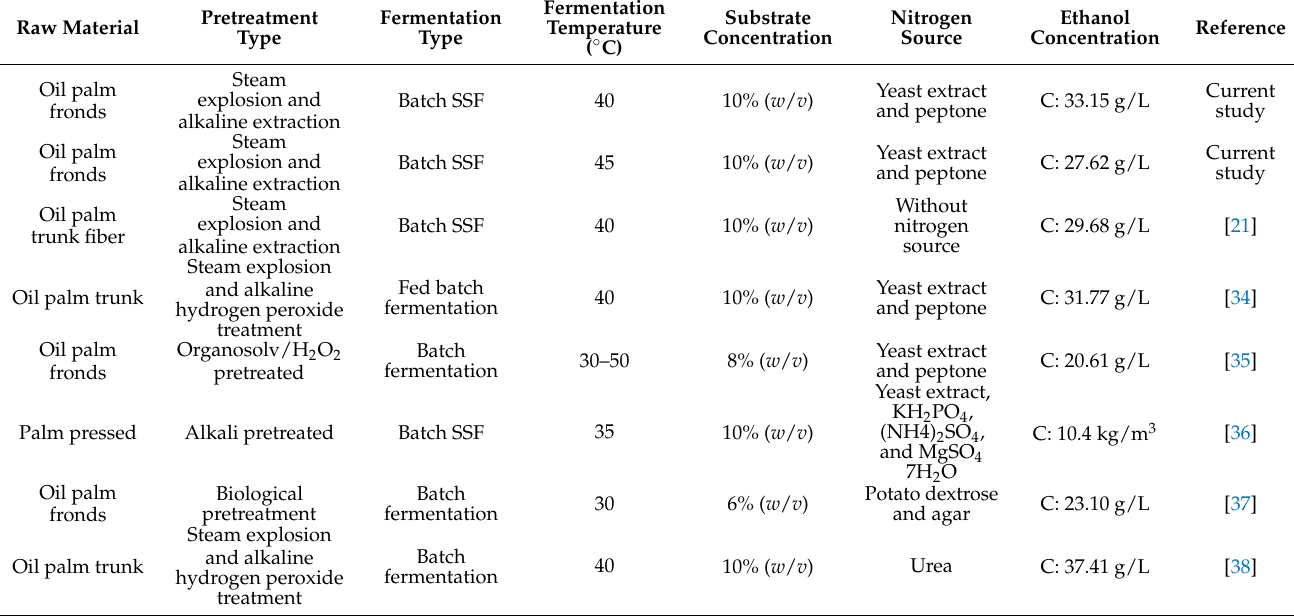
Table 7. Comparative analysis of the current study with previous relevant studies for the production of